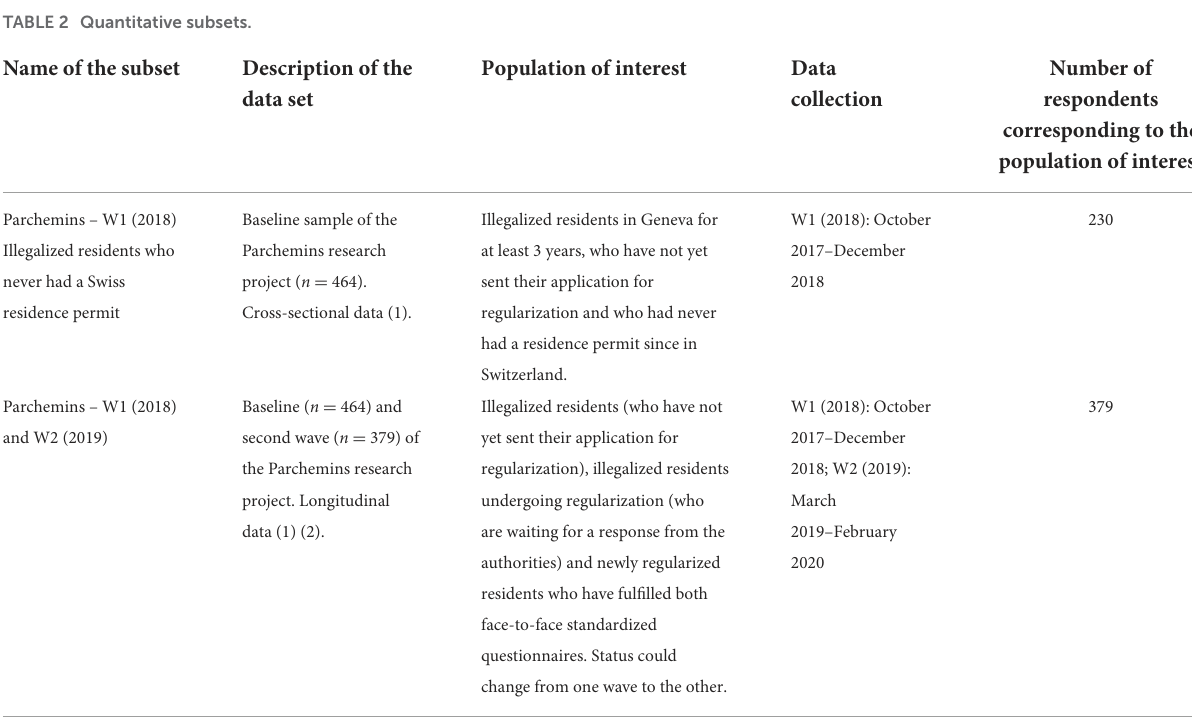
TABLE 2 Quantitative